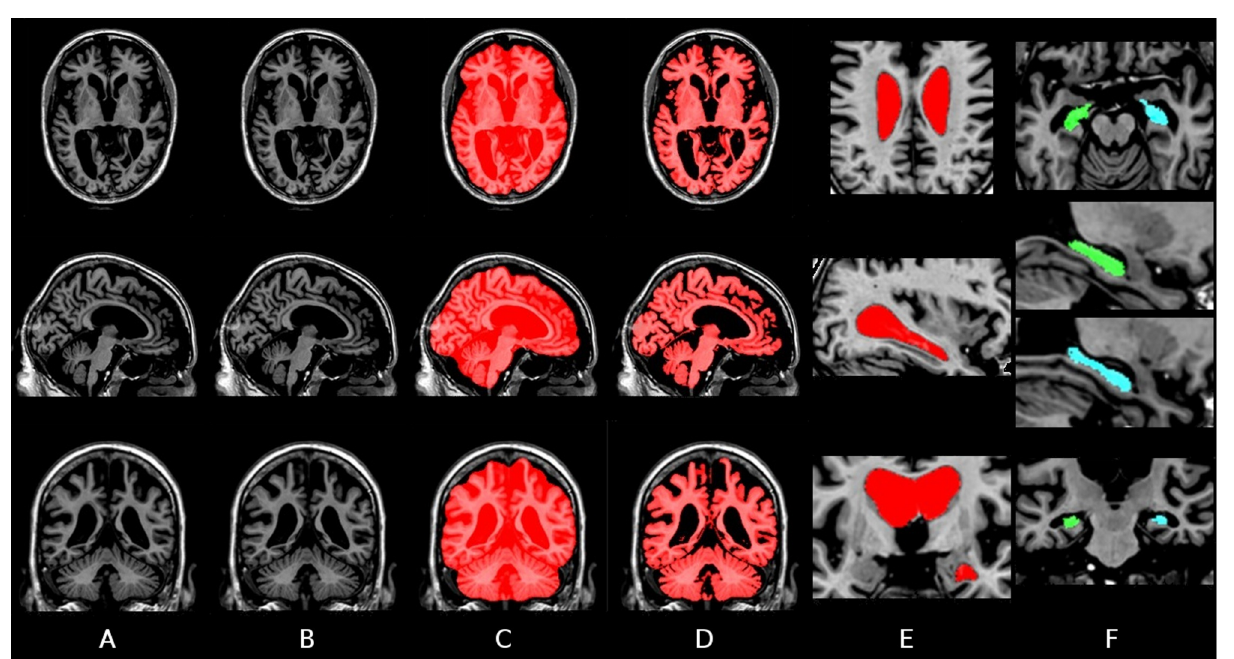
Fig 3. Individual LIT template segmentations of an AD subject from ADNI. Axial, sagittal and coronal slices are presented with from left to right: A) Linear individual template, B) non-linear individual template, C) BEaST skull-stripped mask, D) brain mask, E) lateral ventricle mask and F) right (blue) and left (green) hippocampus mask.